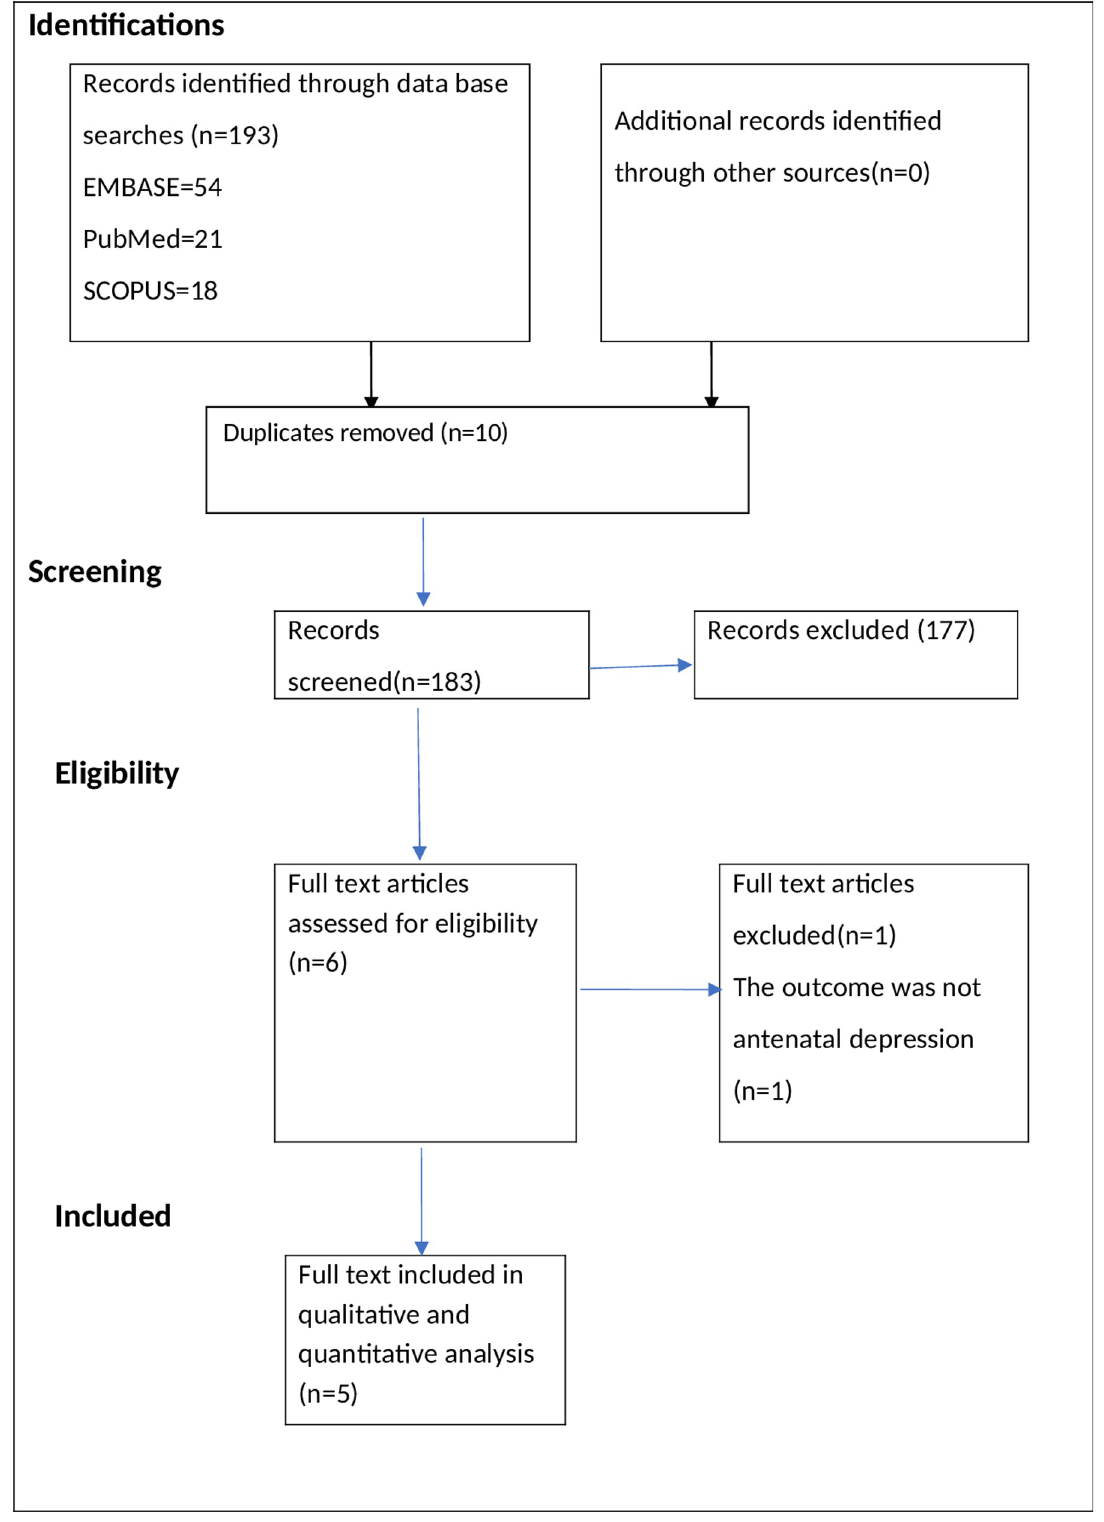
Fig 1. PRISMA flowchart of review